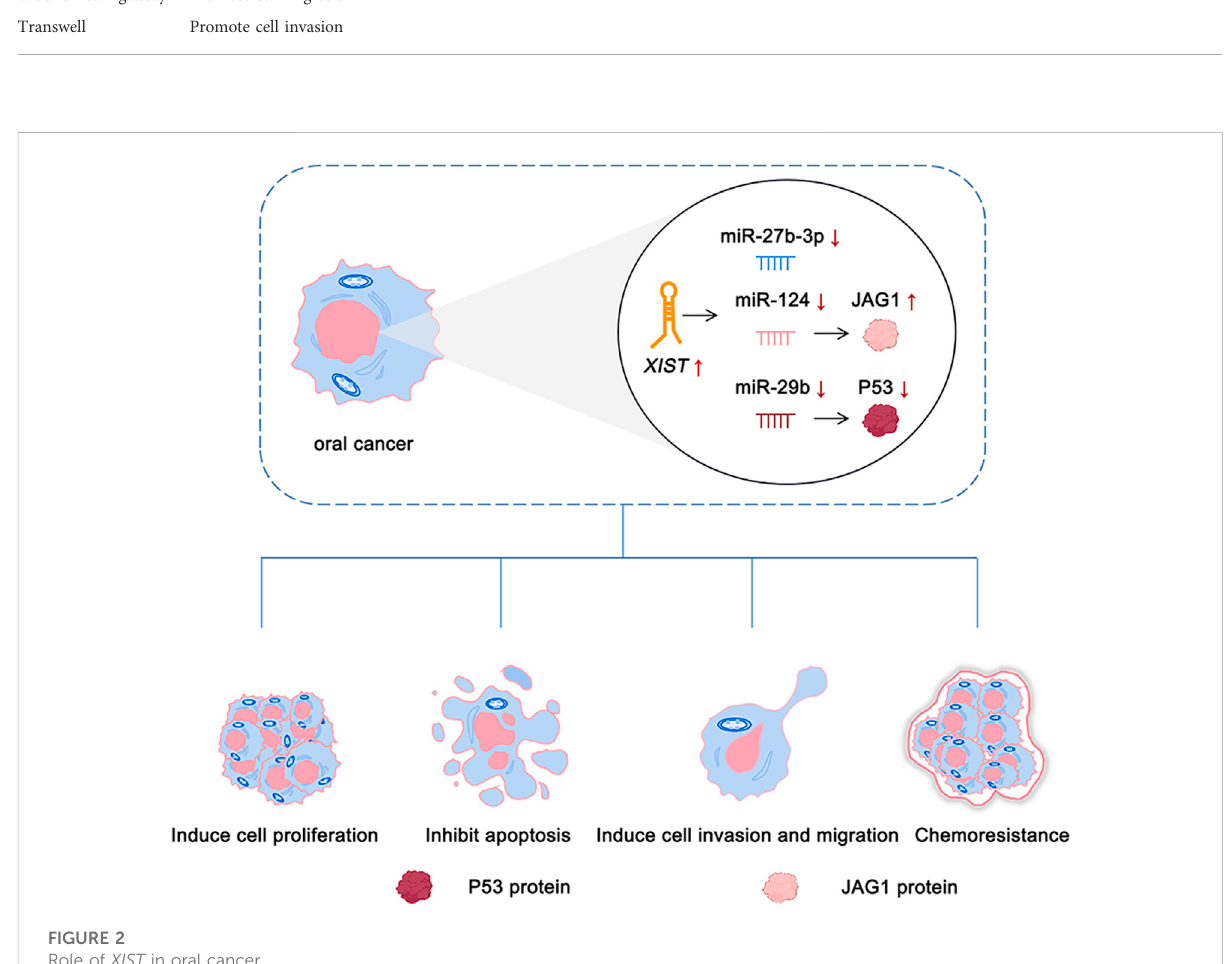
FIGURE 2 Role of XIST in oral